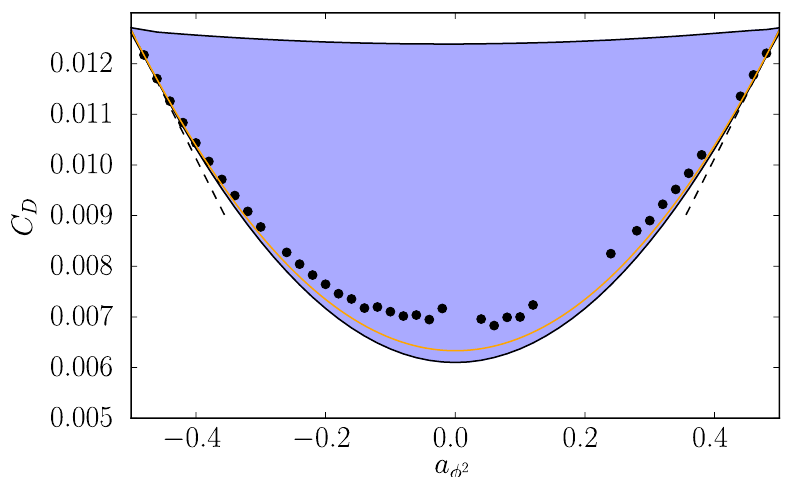
Figure 9. The allowed region for the displacement central charge with minimal model b.c. results (extracted with the extremal functional method) given by black dots. The dotted lines on either side are the first-order predictions of conformal perturbation theory while the orange line in between is the C versus a curve realized by D φ 2